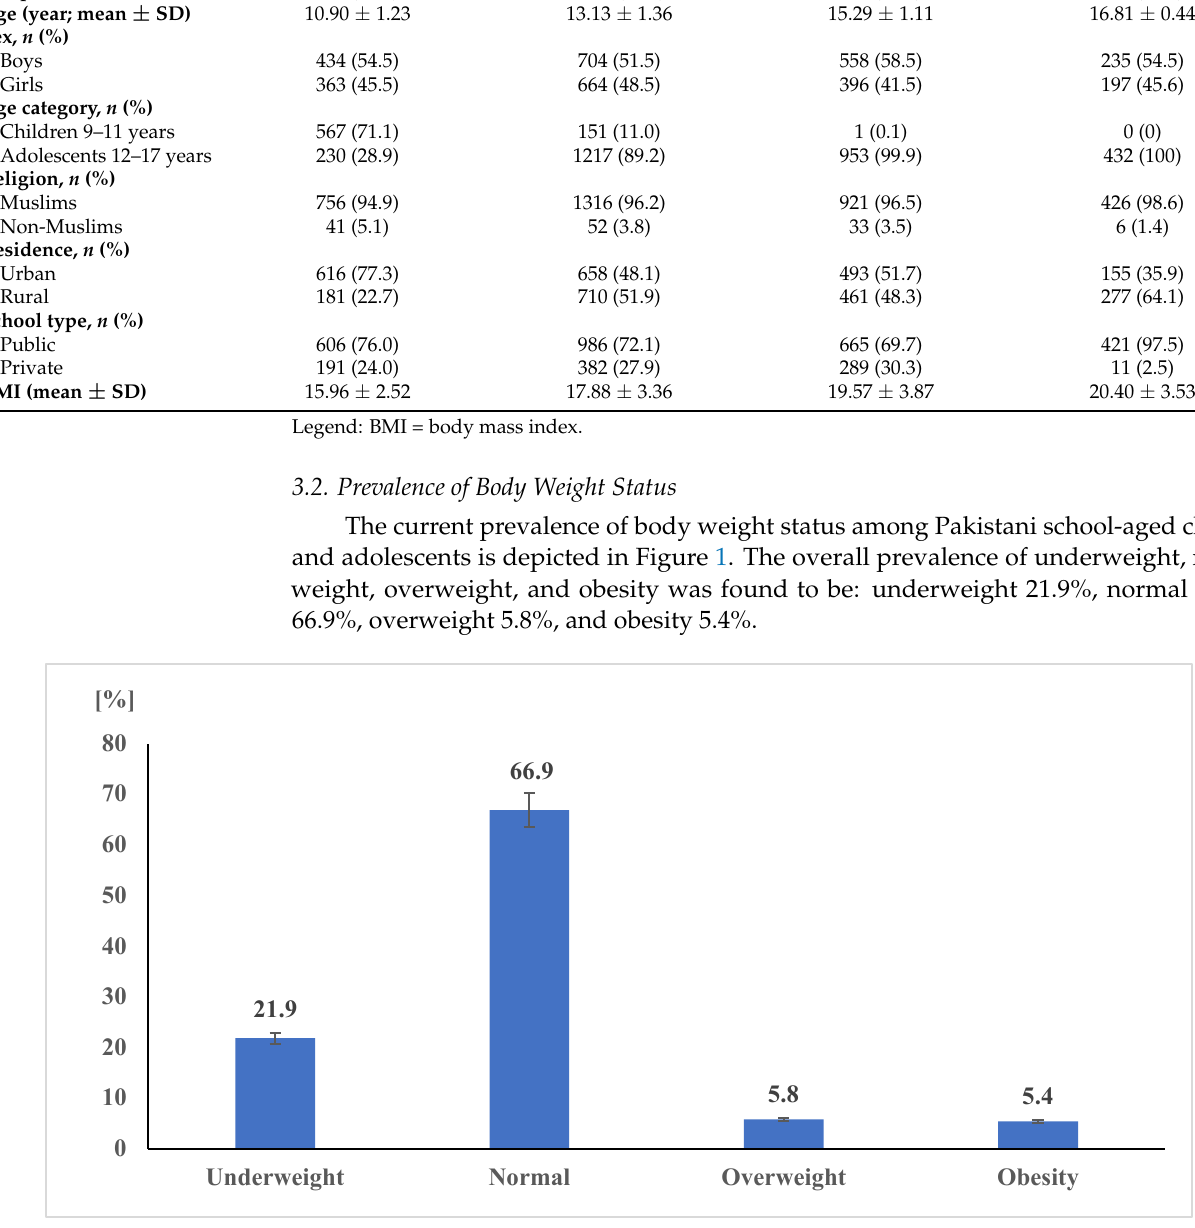
Table 2. Correlation coefficient between body weight status and demographic characteristics. Variable